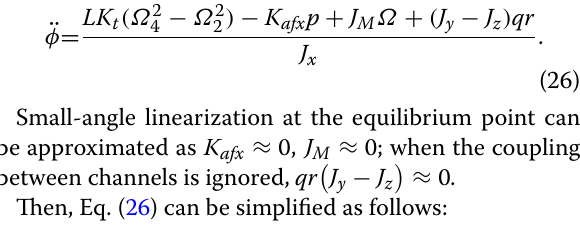
Figure 3 Adaptive controller of attitude tracking for the quad-rotor based on LADRC